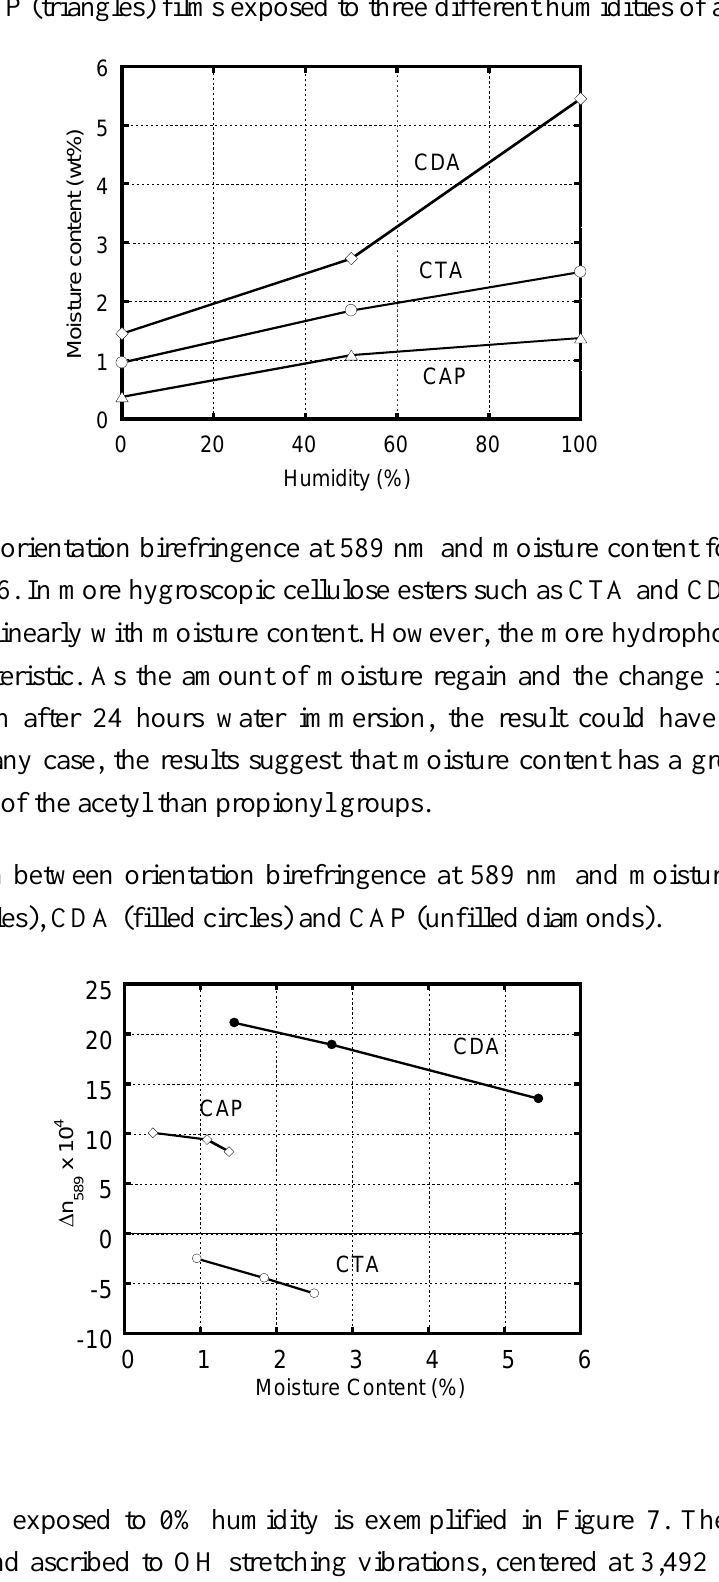
Figure 5. Relation between moisture content and humidity for drawn CTA (circles), CDA (diamonds) and CAP (triangles) films exposed to three different humidities of ambiences.